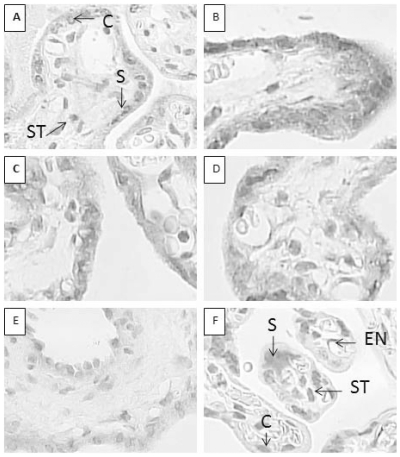
HERVWE1 staining of discordant twin, concordant twin, and singleton placentas.A–F show placental tissues with HERVWE1 immunohistochemical staining. The paraffin-embedded placental tissues were sliced into 4-mm sections. The slices were incubated in a rabbit polyclonal anti-human endogenous retrovirus IgG primary antibody (diluted 1∶100). A goat anti-rabbit secondary antibody (diluted in 1∶200) was applied sequentially. The slices were developed with an immunoperoxidase system. The HERVWE1 antigen was mainly present in the trophoblast cytoplasm. The positive cells were stained brown, and the negative cells were stained blue after counterstaining with hematoxylin. (A) The larger infant in discordant group (magnification 10×40). (B) The smaller infant in discordant group (magnification 10×40). (C) The larger infant in concordant group (magnification 10×40). (D) The smaller infant in concordant group (magnification 10×40). (E) A singleton infant (magnification 10×40). (F) The negative control (magnification 10×40). This singleton tissue slice was stained with 1% gelatin instead of the HERVWE1 antibody. Syncytiotrophoblast, cytotrophoblast, stromal cells, and endothelial cell are marked as S, C, ST, and EN respectively.